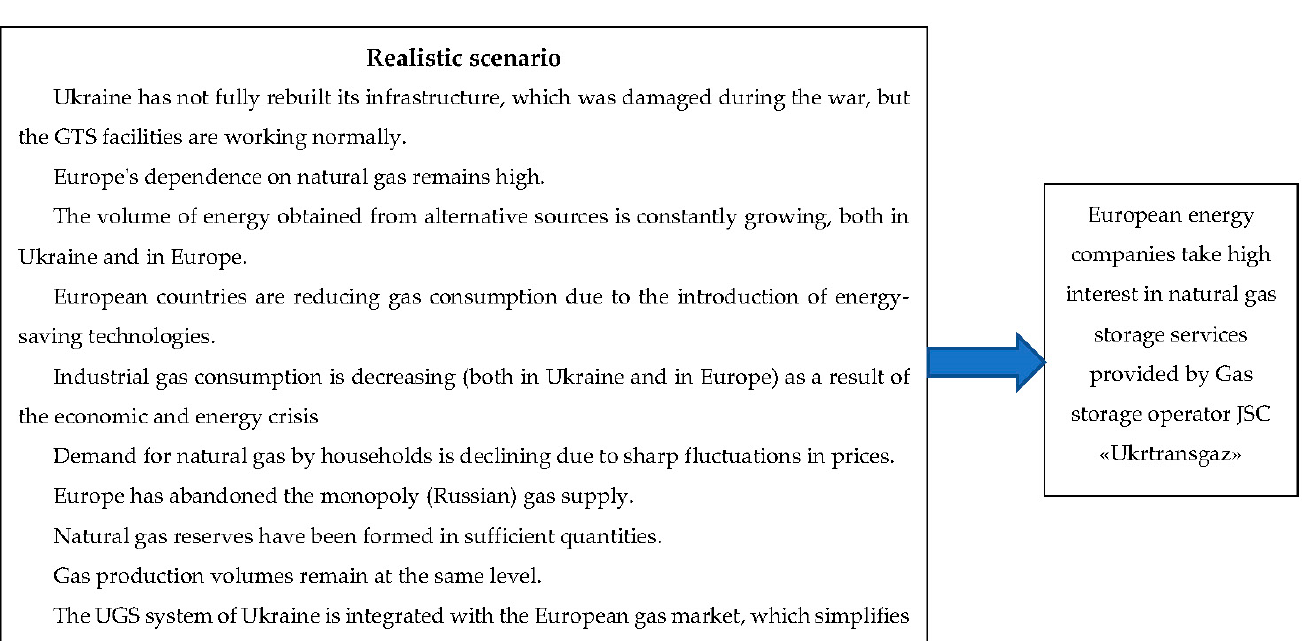
Figure 12. Pessimistic scenario.